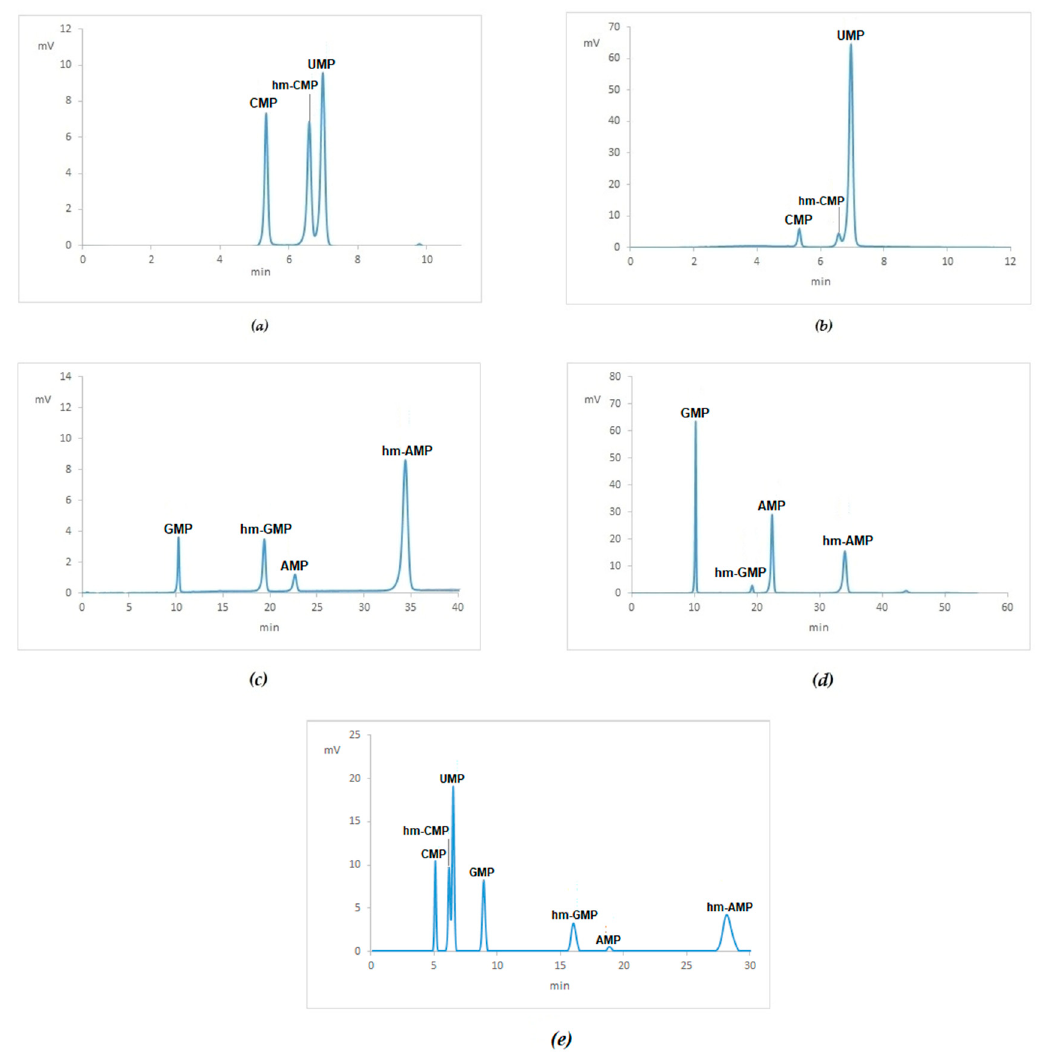
Figure 2. Resolution of NMPs and hm-NMPs by HPLC analysis: ( a ) Mixture of CMP and UMP treated with 4% neutral bu ff ered formaldehyde; ( b ) the same mixture of ( a ) with the addition of UMP; ( c ) mix of GMP and AMP treated with 4% neutral bu ff ered formaldehyde; ( d ) the mixture of ( c ) with the addition of AMP and GMP; ( e ) mixture of the four NMPs treated with 4% neutral bu ff ered formaldehyde.